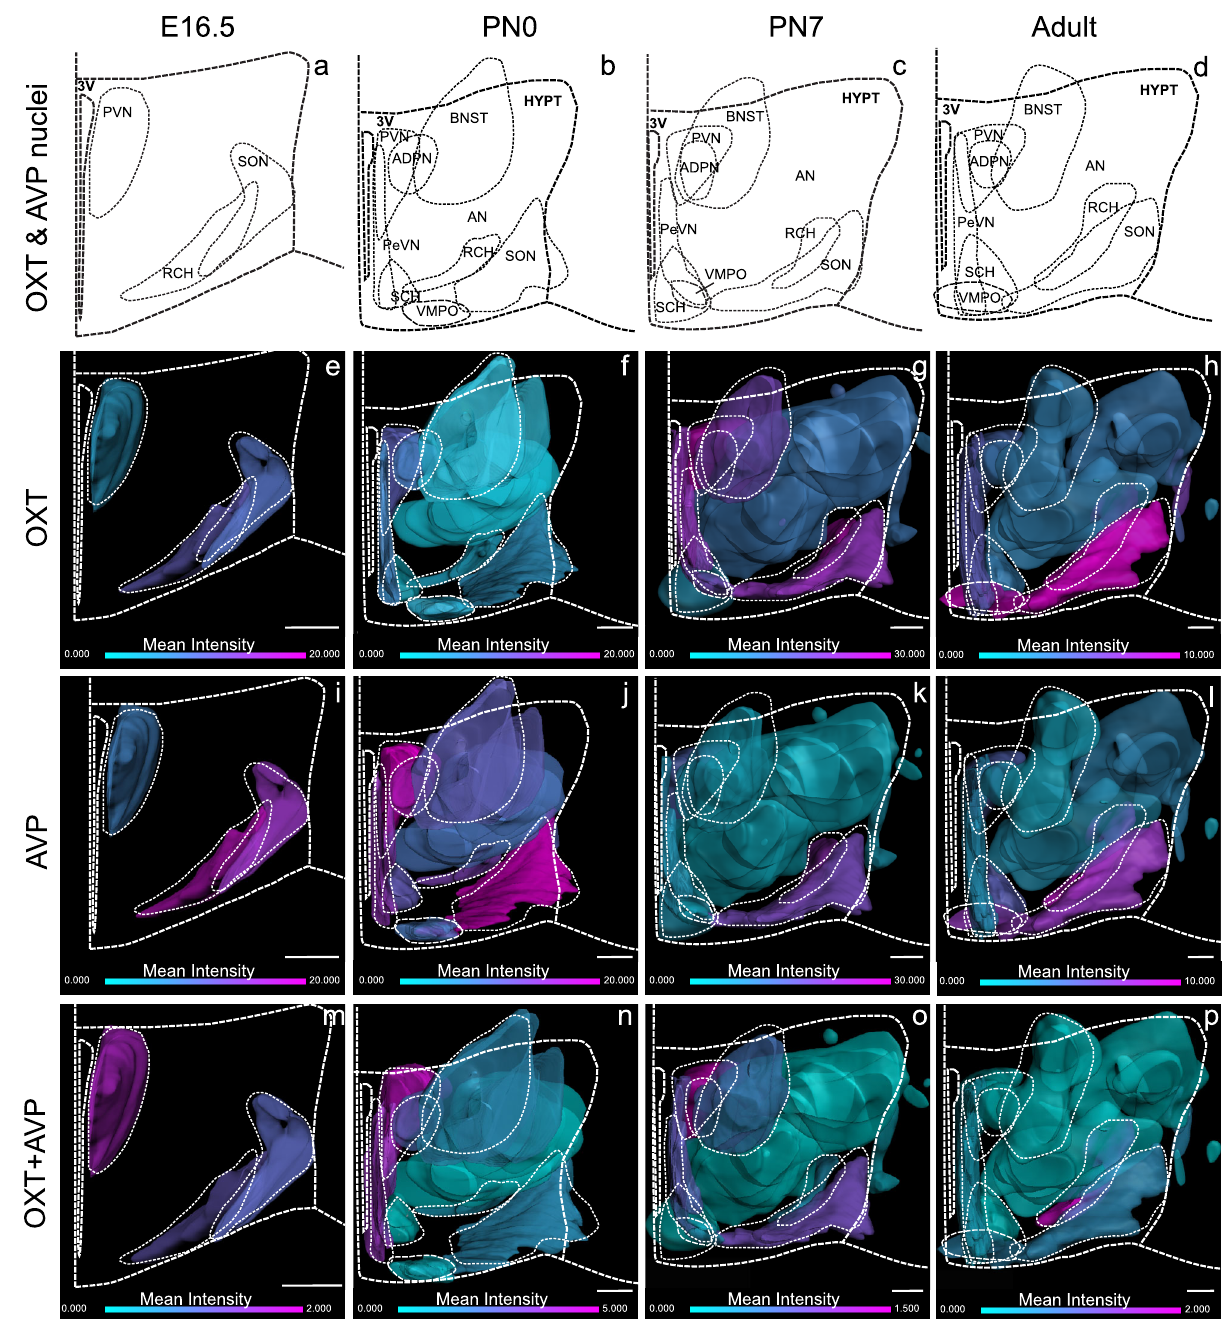
Fig. 3 OXT, AVP, and OXT + AVP cell density in the developing mouse hypothalamus. 3D hypothalamic fl atmap representations of OTX ( e – h ), AVP ( i – l ) and OXT + AVP cells ( m – p ) in each nucleus at a range of developmental stages: E16.5 ( a ), PN0 ( b ), PN7 ( c ) and adult ( d ). Flatmaps show the expression intensity of each cell population at each developmental stage. Please note the difference intensity scale according to the developmental stage. The minimum intensity is represented in turquoise and the maximum in pink. 3v third ventricle, PeVN periventricular nucleus, ADPN anterodorsal preoptic nucleus, BNST bed nucleus of stria terminalis, VMPO ventromedial preoptic nucleus, SON supraoptic nucleus, PVN paraventricular nucleus, RCH retrochiasmatic area, AN accessory nucleus, SCH suprachiasmatic nucleus. Scale bar: 200 µ